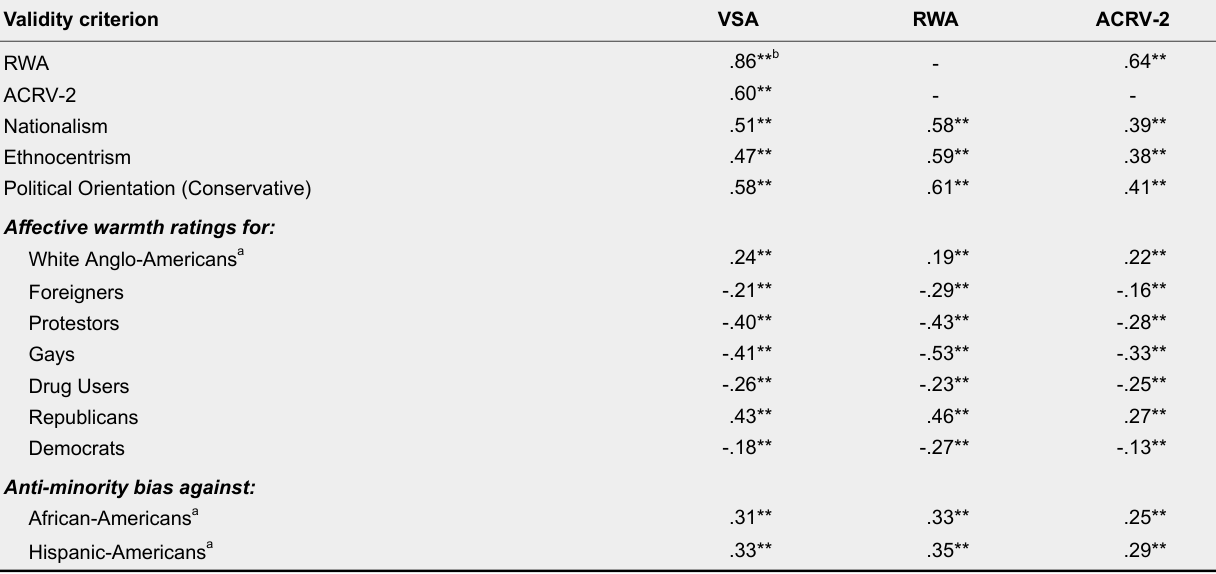
Correlations of the VSA, RWA, and ACRV-2 Scales With Validity Indicators of Authoritarianism for the Second US Sample (N = 395) ACRV-2RWAVSAValidity